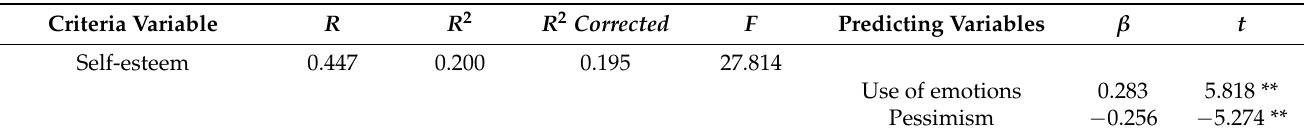
Table 6. Linear regression analysis, criteria variable: